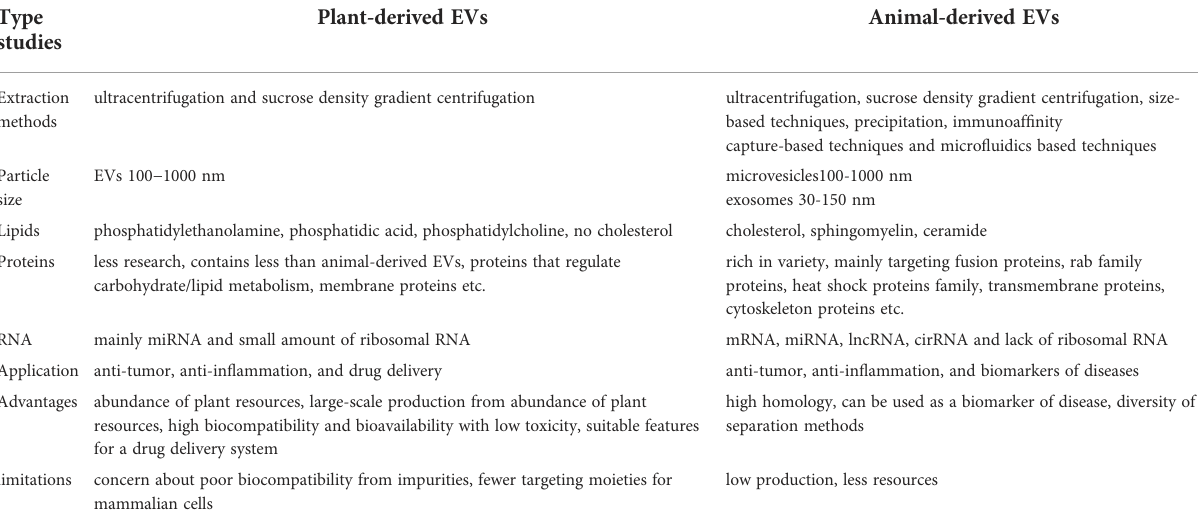
TABLE 2 Comparison of plant-derived EVs and animal-derived